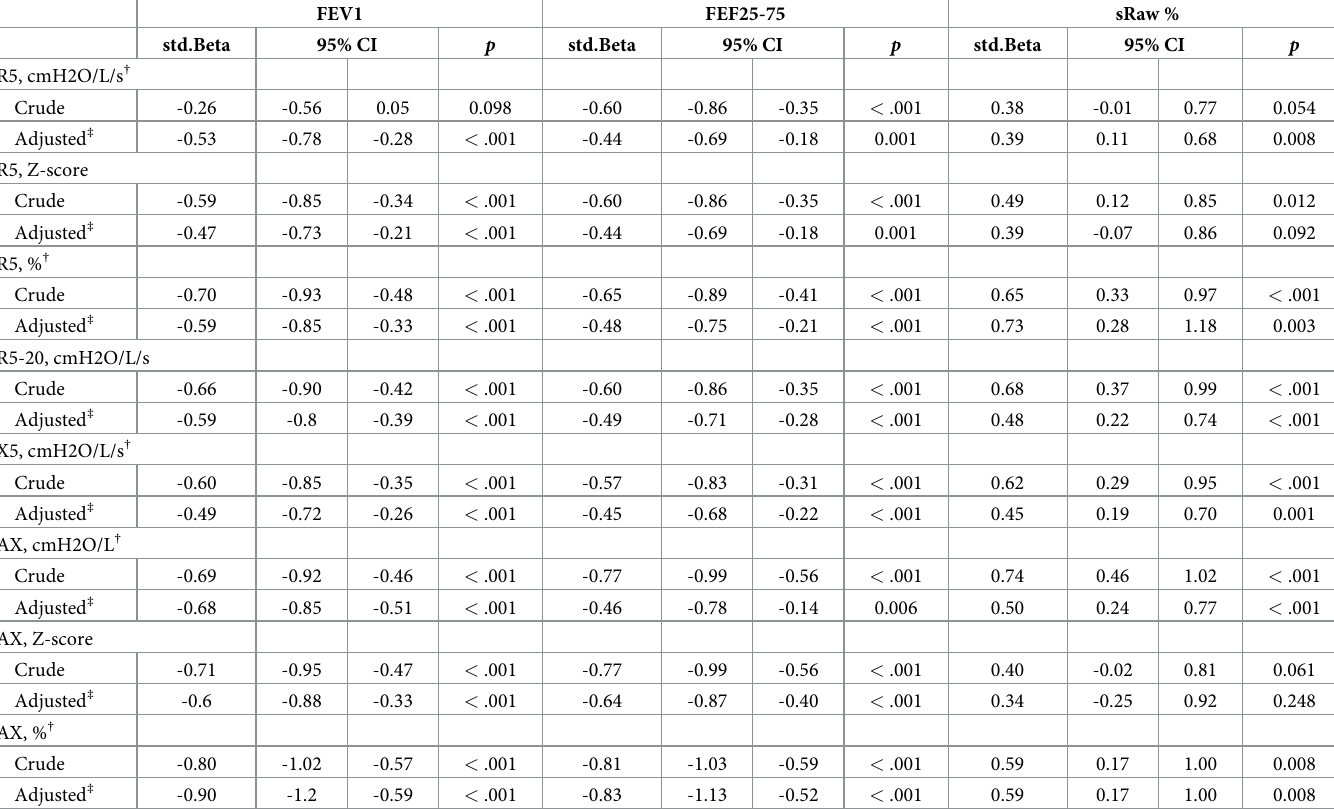
Table 2. General linear regression analysis of airway resistance and reactance parameters between IOS, spirometry, and plethysmographic